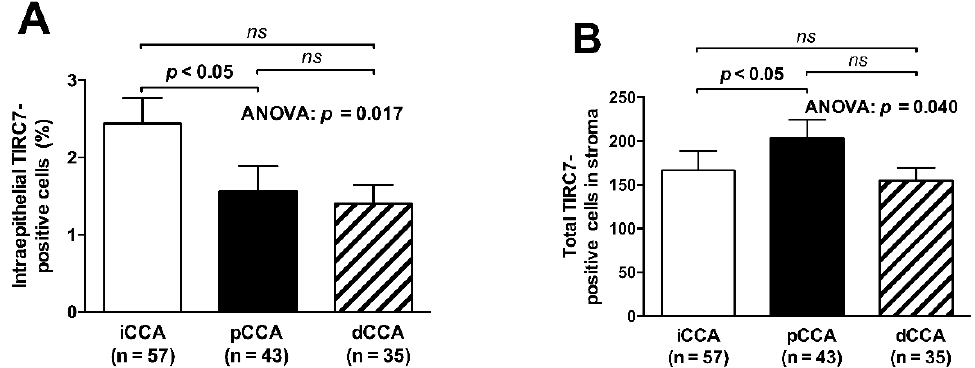
Figure 3. Intergroup analysis of TIRC7 + immune cell quantity in tumor tissue. Intraepithelial density of TIRC7 + immune cells was significantly different among the three CCA subgroups with significantly higher levels in iCCA compared to pCCA cases ( A ). With respect to the stromal compartment, the total number of TIRC7 + cells differed between the groups, being significantly higher for pCCA as compared to iCCA ( B ). Overall group differences were assessed using the Kruskal–Wallis followed by Dunn’s test for post hoc pairwise comparisons. Data are depicted as mean ± standard error of the mean.